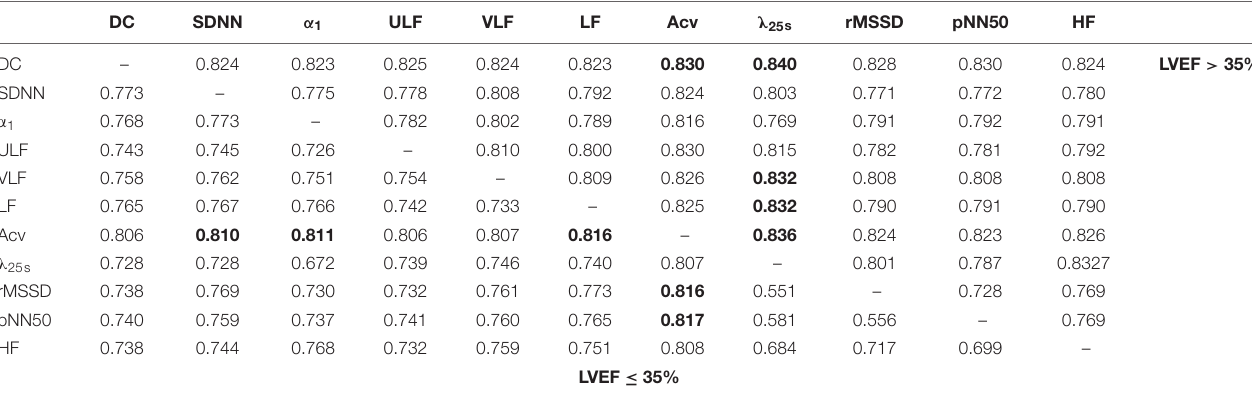
Data are c-statistics calculated by logistic regression analysis. Values in lower left half and upper right half represent those for patients with LVEF ≤ 35% and those with LVEF > 35%, respectively. Boldface indicates the top five largest values for LVEF ≤ 35% and LVEF > 35%, respectively. All classification models are adjusted for the effect of age. Abbreviations are explained in the legend of Figure 1